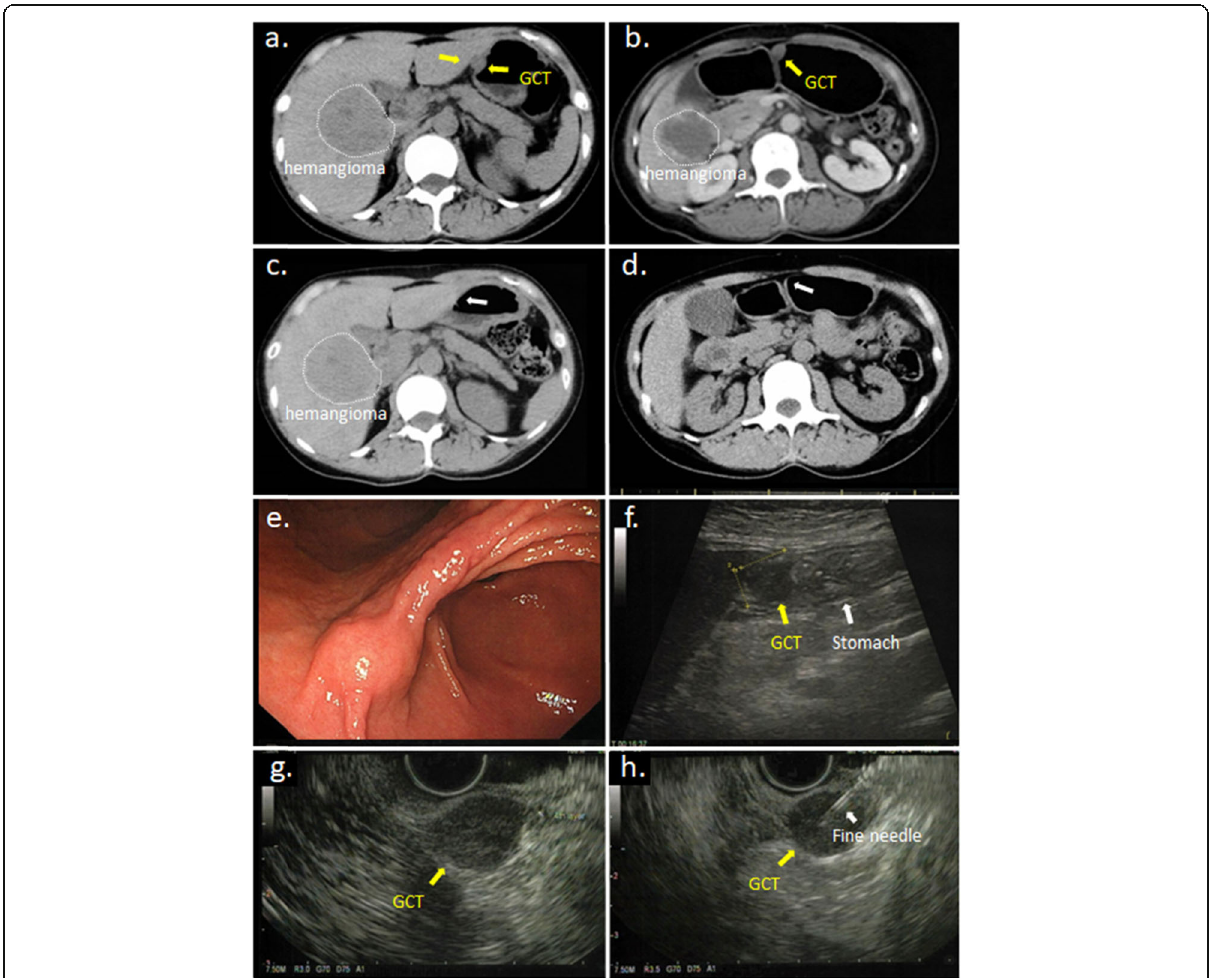
Fig. 1 a Abdominal computed tomography (CT) revealed a solid extramural tumor situated at the lesser curvature of the lower body of the stomach (yellow arrow). The portion surrounded by white dotted line is hepatic hemangioma. b CT using foaming agent showed it more clearly. c The CT scan performed one year ago and d 4 years ago showed the tumor did not exist (white arrow). e Gastroscopy revealed submucosal tumor at the anterior side of the angle of the stomach. f Abdominal ultrasound sonography showed a low echoic mass measuring 15 mm in diameter existed in contact with the stomach. g Endoscopic ultrasound sonography (EUS) showed that the tumor of about 15 mm in diameter occurred from the fourth layer of the gastric wall and h the needle of EUS-guided fine needle aspiration biopsy (EUS-FNA) surely punctured to the